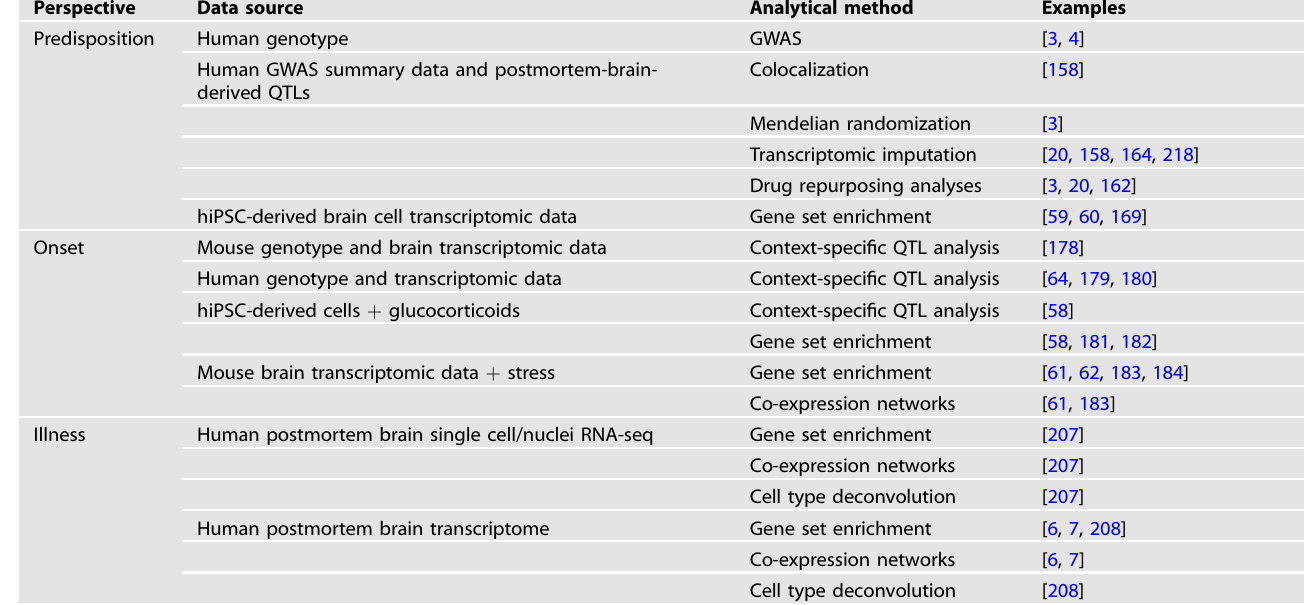
Table 1. Summary of analytical methods in the context of the conceptual framework (predisposition, onset, illness) with examples of data sources and studies for which these methods are employed.